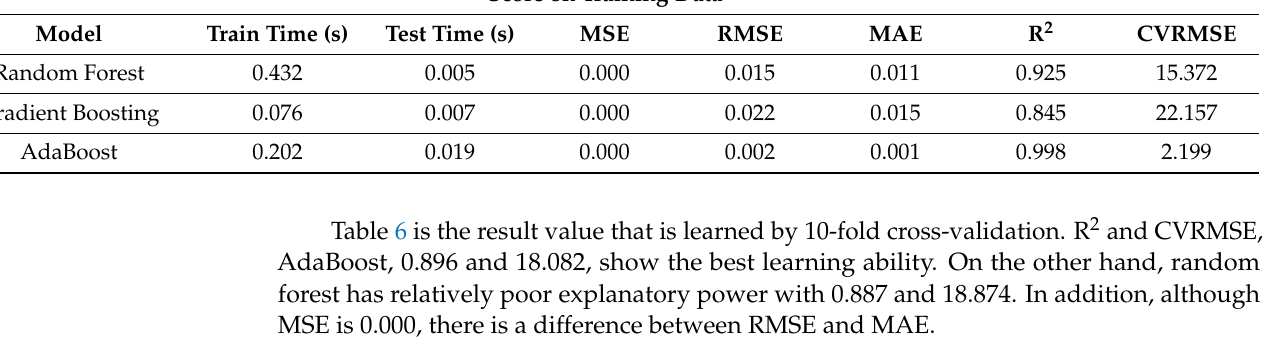
Table 6. 10-fold cross-validation.